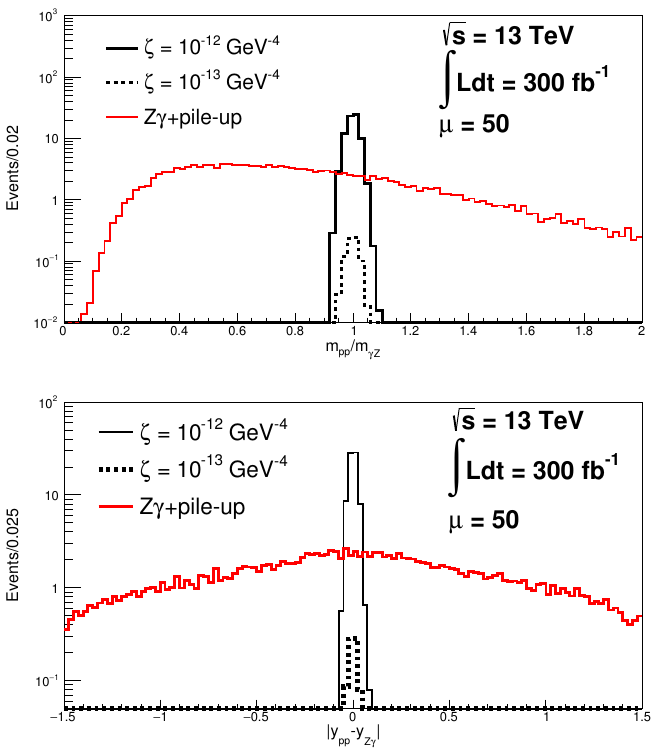
p Figure 3 . Missing diproton mass m pp = (cid:24) 1 (cid:24) 2 s to central mass ratio distribution (top) and rapidity di(cid:11)erence distribution (bottom) in the ‘ (cid:22) ‘(cid:13) channel for signal and background within the acceptance 0 : 015 < (cid:24) 1 ; 2 < 0 : 15 considering two di(cid:11)erent coupling values after applying the requirements on the acceptance, p T , invariant mass m (cid:13)Z , p T ratios and angle separation according to table 2. The width of the signal is due mainly to the (cid:24) 1 ; 2 resolution. The integrated luminosity is 300 fb (cid:0) 1 and the average pile-up is (cid:22) = 50.